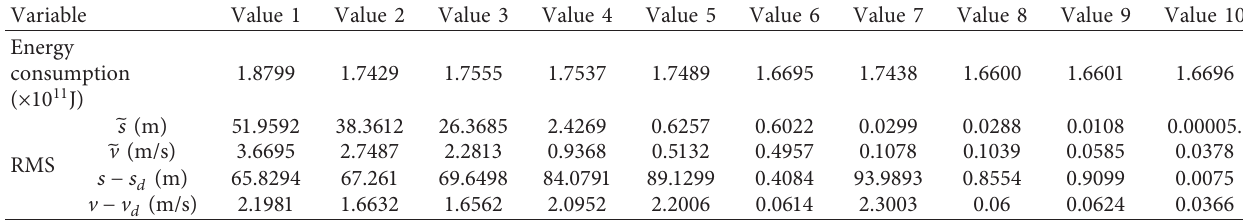
Table 3: Energy consumption and RMS for different parameters.